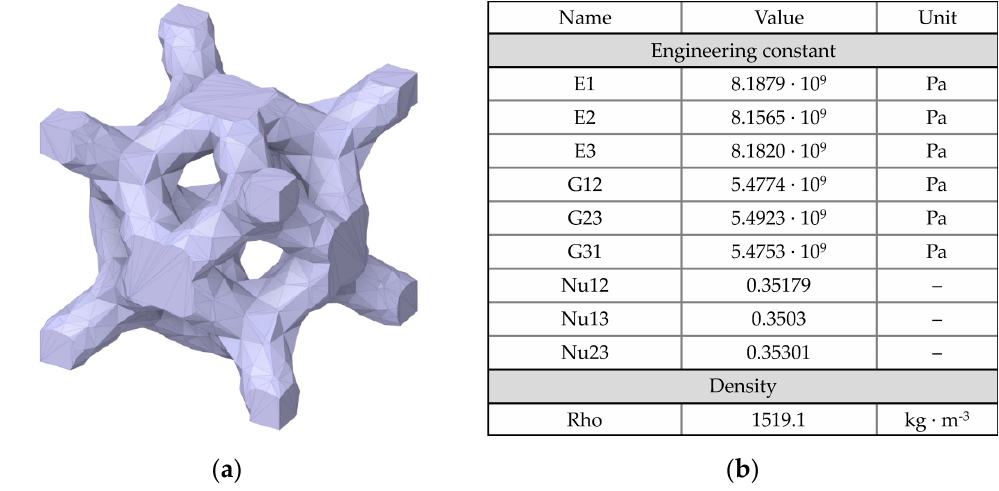
Figure 6. Surface model of pelvis obtained by computer tomography: ( a ) before surgery; ( b ) after surgery.